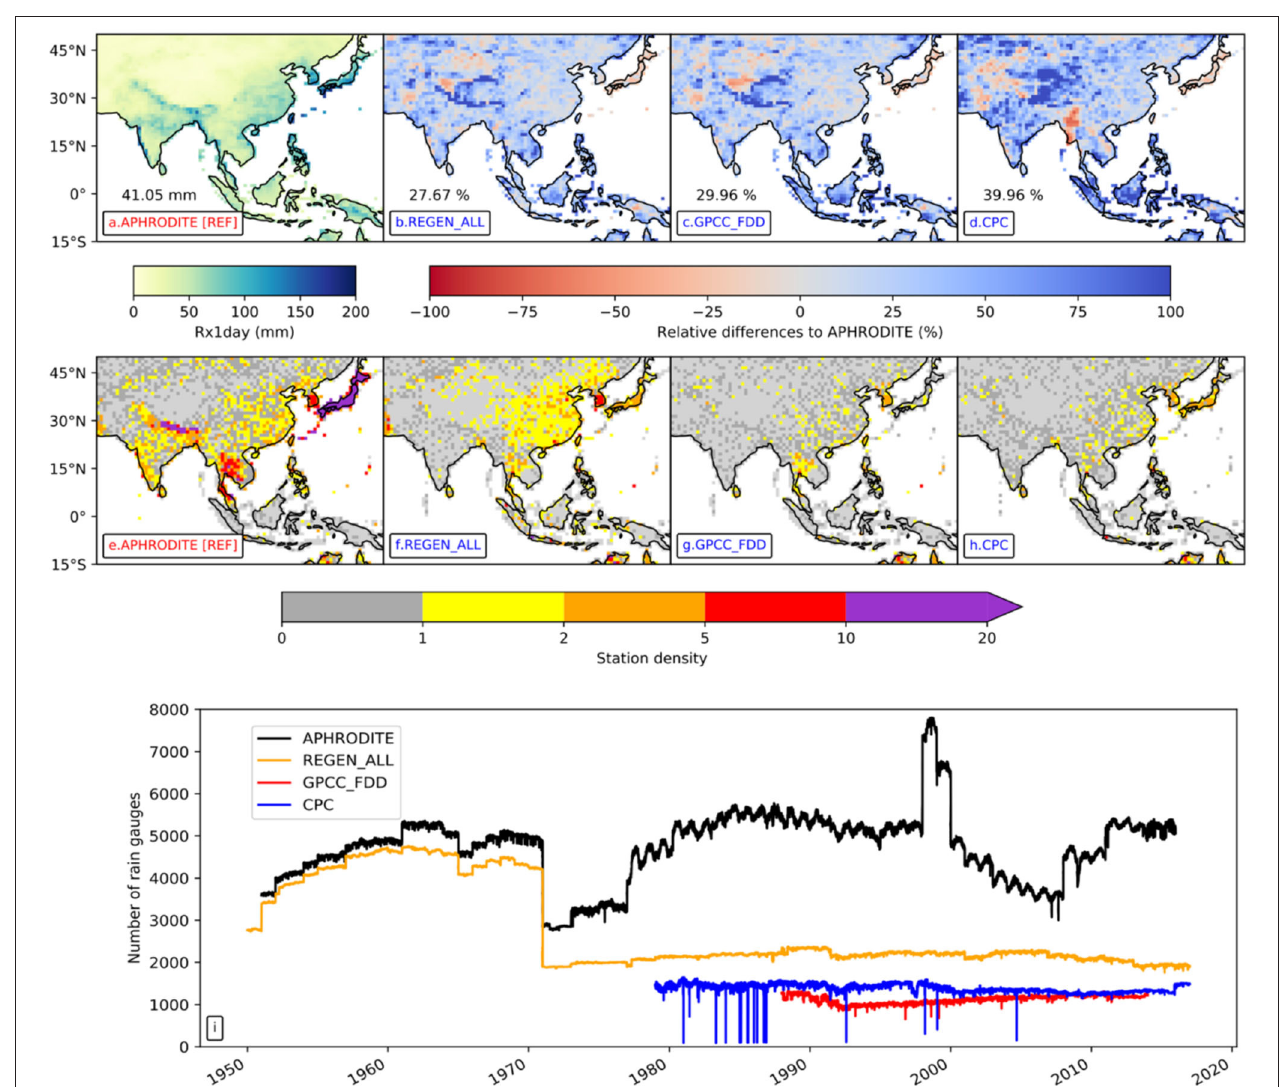
FIGURE 2 | Upper panel: Climatological values (over the period of 2001–2013) of the annual wettest-day (Rx1day; in mm) for (a) APHRODITE and the relative difference to APHRODITE (in %) of climatological Rx1day for the in situ -based products (blue labels): (b) REGEN_ALL (c) GPCC_FDD, (d) CPC. The number inserted on each panel indicates the regional average of these relative differences. Middle panel: Climatological station density in each in situ -based dataset: averaged number of rain gauges per 1 ◦ x1 ◦ grid cell over the 2001–2013 period in (e) APHRODITE, (f) REGEN_ALL, (g) GPCC_FDD, (h) CPC. Note that the light gray color indicates no station and the dark color indicates very sparse-station regions (i.e., have station density < 1 station per grid cell). Bottom panel: (i) Time evolution of station density: daily total number of rain gauges over the Asian Monsoon area in (black) APHRODITE, (orange) REGEN_ALL, (red) GPCC_FDD, and (blue) CPC.